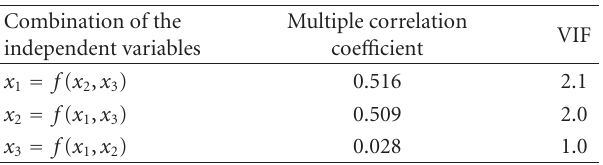
Table 2: Nonmulticollinearity test results between the three inde- pendent variables.